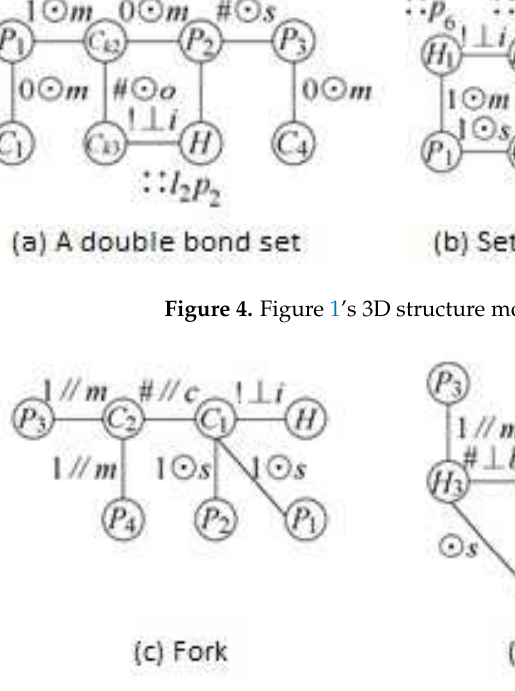
Figure 5. Figure 2’s 3D structure